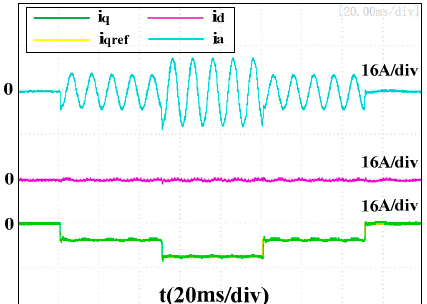
Figure 13. d-q axis current waveform of the proposed accurate discrete current controller at 6000 rpm with Kdq = 500 π Ls.